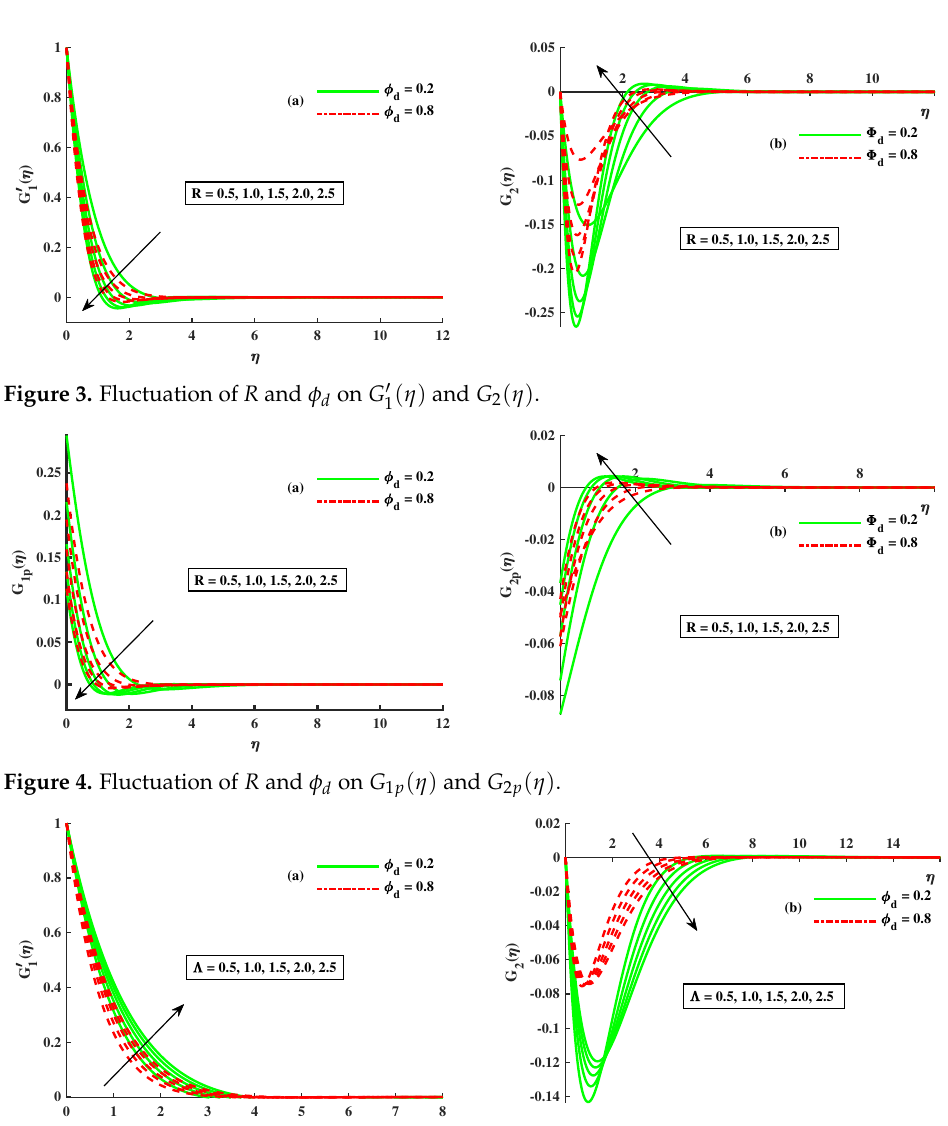
( η ) and G ( η ) . Figure 5. Fluctuation of Λ and φ d on G (cid:48) 2 1 Figure 6a,b demonstrate the affect of Λ and volume concentration of dust particles on dusty phase velocities G 1 p and G 2 p . It can be seen that G 1 p velocity increased and G 2 p ve- locity decreased with incremental values of material parameters; both velocities decreased with higher inputs of dust particle concentration. Figure 7a,b display the variation in micro-rotation distribution profile with varying inputs of rotational, material parameter, and concentration of dust particles. From Figure 7a, we can see that the micro-rotation profile was amplified with larger inputs of R , whereas it was reduced against higher inputs of dust particle concentration. Figure 7b reveals that micro-rotation was improved with increasing inputs of Λ parameters. Figure 8a,b illustrate the impact of R and φ d on the tem- perature and dust phase of the fluid. It is obvious that the temperature of fluid and dusty phase increased with increasing inputs of R and φ d . Basically, the development of heat is satisfied on the base of a higher diffusion process because of increased rotation. Figure 9a,b represent the fluctuation in θ and θ p by different values of the material parameter and φ d . The fluid temperature and dust phase temperature depreciate against magnified inputs of the material parameter; both phase temperatures rise with larger inputs of φ d . Physically, the higher input of dust particles enhance the base fluid dust concentration, which causes the fluid velocity to decrease; however, the base fluid temperature increased due to the thermal conductivity of the additional dust